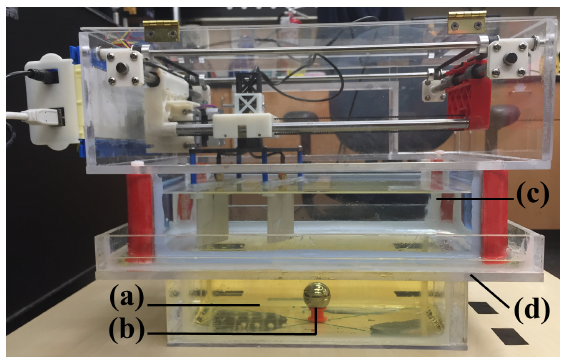
Figure 8. The relative permittivity (cid:101) r ( left ) and conductivity σ ( right ) of sunflower oil (solid blue) are close to the behavior of breast fat (dotted green) for the selected frequencies when compared to that of other breast tissues such as fibro-glandular tissue (dashed red) [141,142].